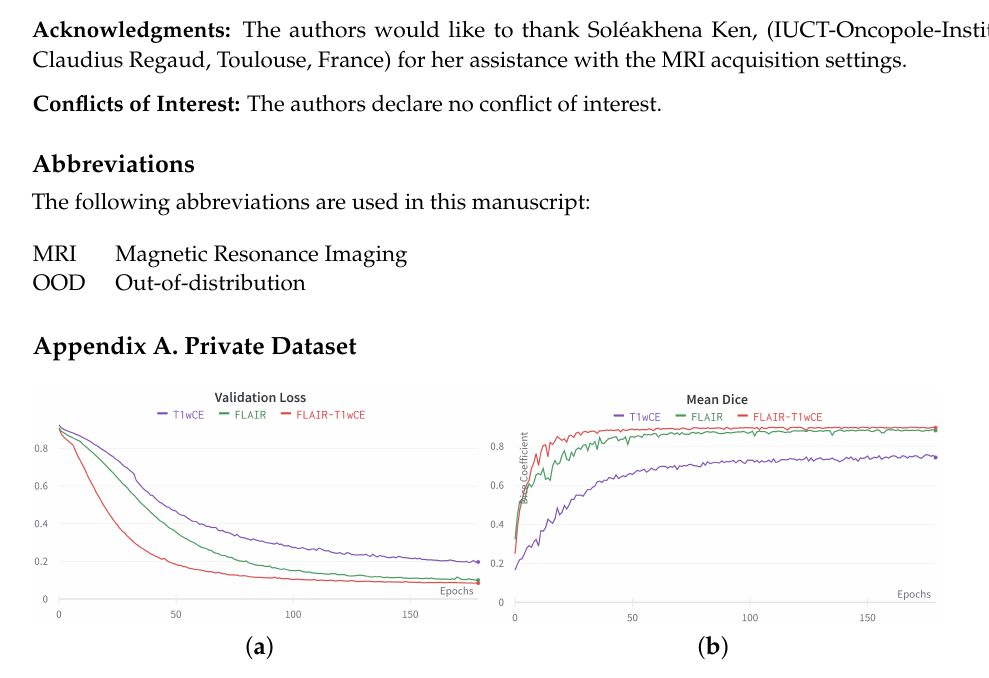
Figure A1. Validation loss ( a ) and dice coefficient ( b ) for the tumor segmentation on the private dataset.